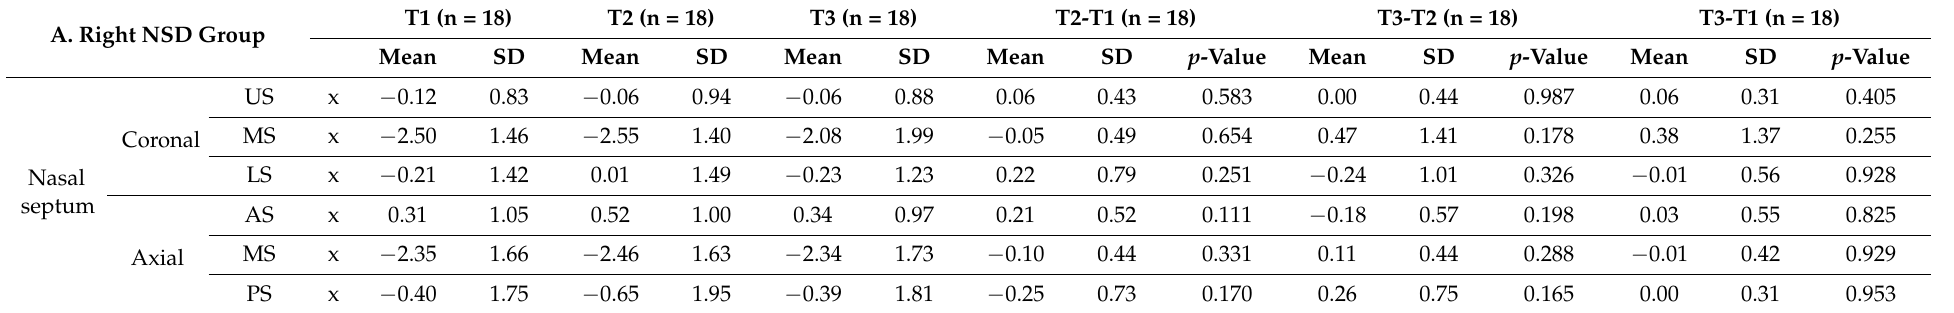
Table 4. Three-dimensional values and changes of nasal septum and nasofacial structures after MSE depending on the direction of